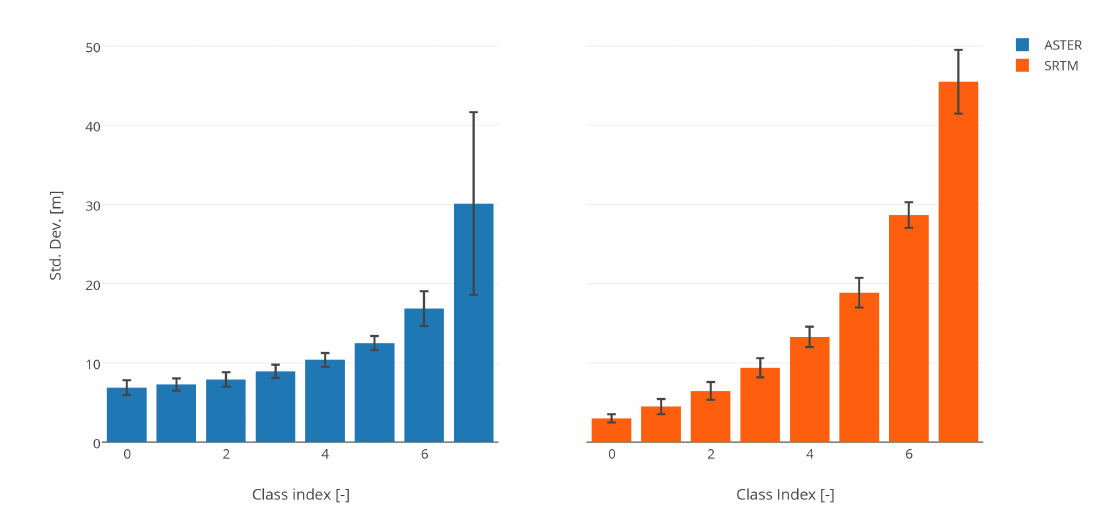
Figure 5: SRTM vs ASTER Std.Dev. analysis